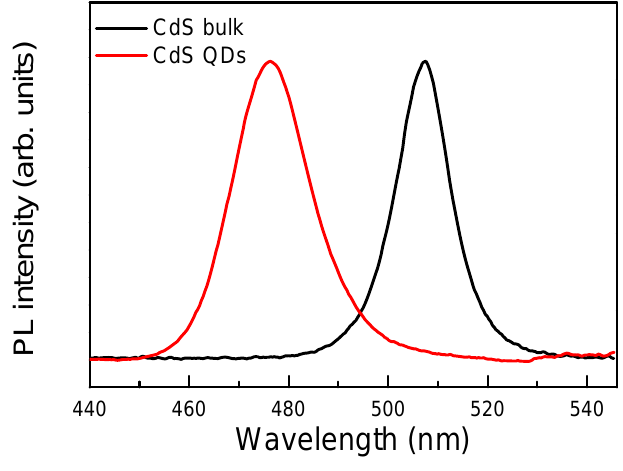
Figure 1. Photoluminescence spectra for CdS quantum dots (QDs) and bulk samples. Peak intensities are normalized to the same level.